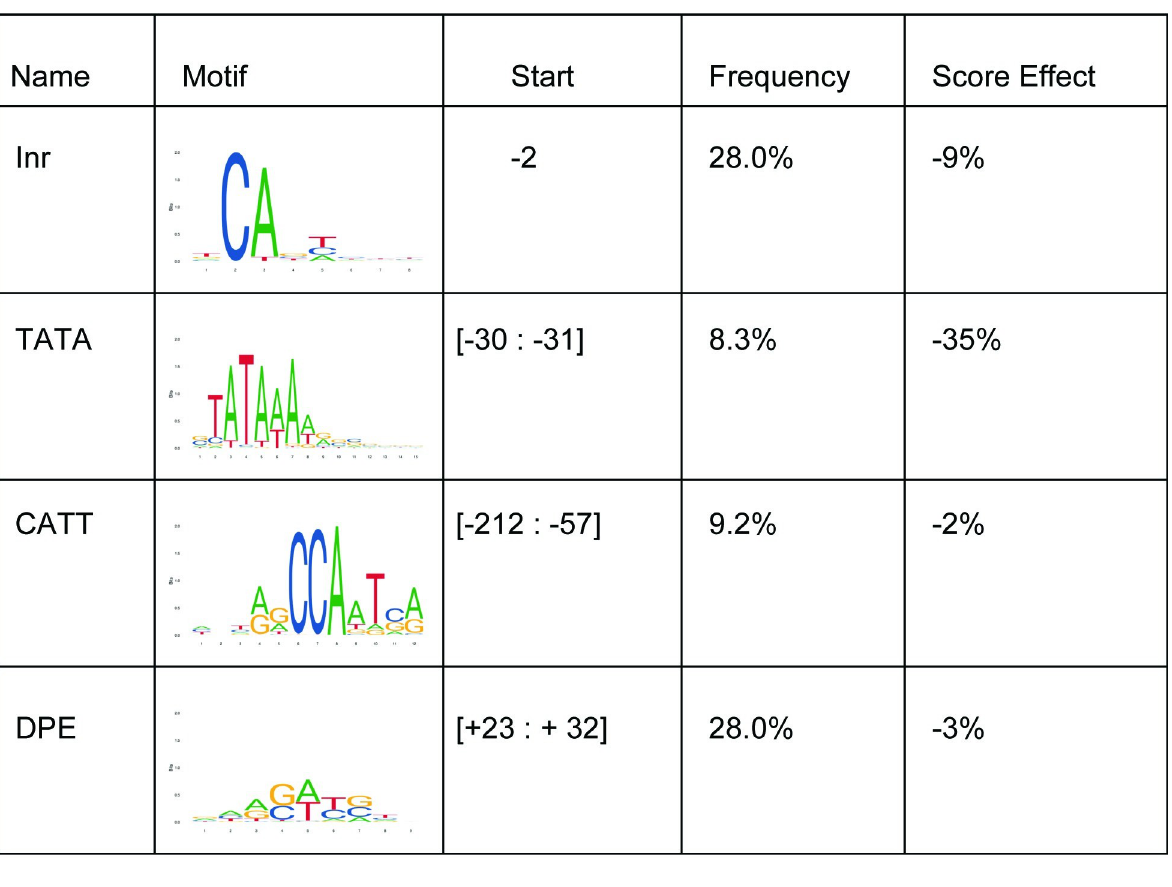
Fig 3. Effect of substituting promoter conserved motifs with random nucleotides on the score predicted by the deep learning model.